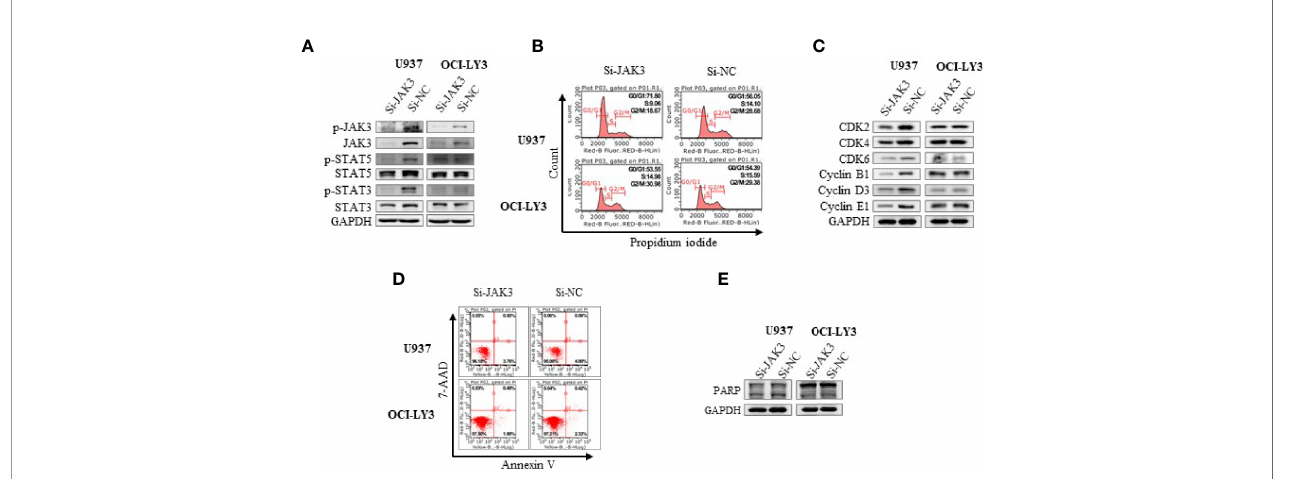
FIGURE 2 | Si-JAK3 suppressed activation of JAK3-STAT3/5 signal pathway and induced G0/G1 phase arrest in U937 cells. (A) Western blotting analysis of whole- cell lysates after electrotransformation of JAK3 siRNA for 72 h, and the JAK3-STAT3/5 signal pathway in U937 and OCI-LY3 cells. The change of cell cycle (B) , cycle-related proteins (C) , cell apoptosis (D) , and apoptosis-related protein (E) was analyzed by fl ow cytometry or Western blotting.